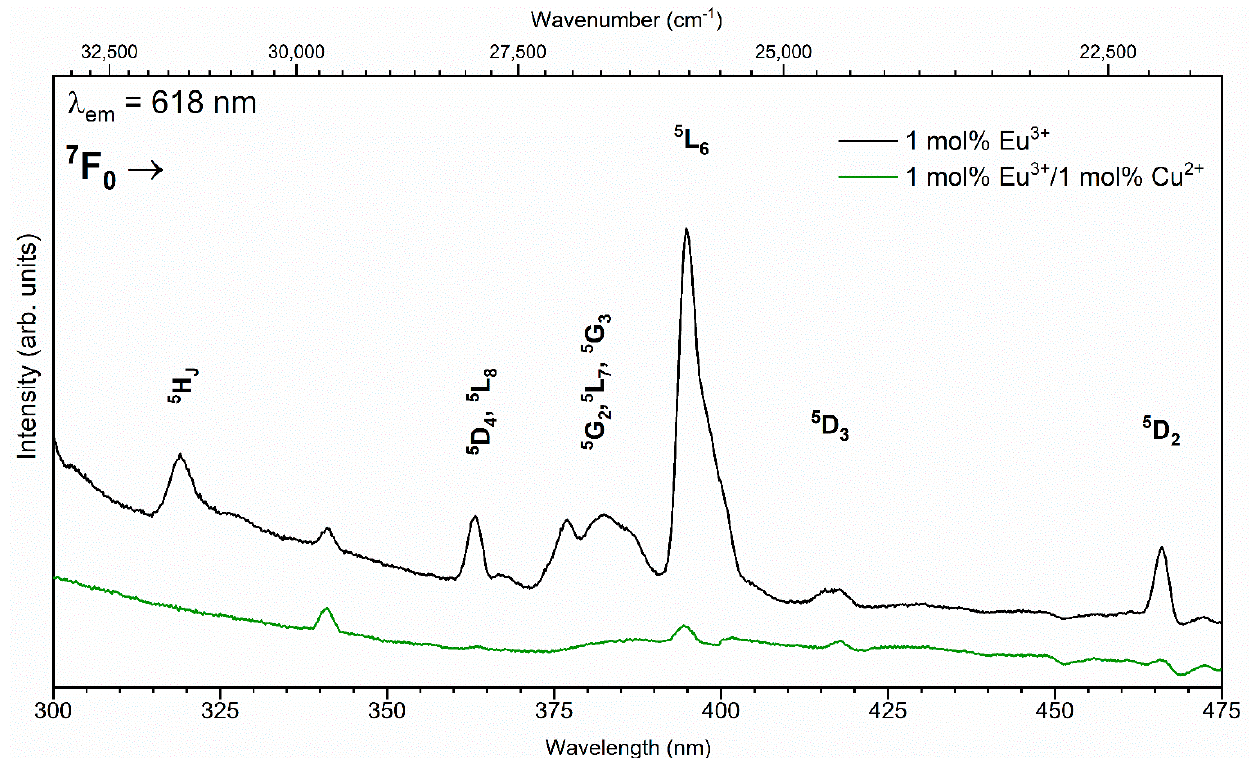
Figure 6. The excitation spectra of the 1 mol% Eu 3+ and 1 mol% Eu 3+ /1 mol% Cu 2+ -co-doped Ca 10 (PO 4 ) 6 (OH) 2 . The spectroscopic properties of Eu 3+ ions allow us to receive vital information about the symmetry of the Eu 3+ ions surrounding the crystal lattice; the amount of crystallo- graphic positions; and therefore, potential sites of substitution, structural changes occur- ring in the matrix caused by external factors, etc. The emission spectra of the Eu 3+ ions consist of characteristic bands present in the red region of the electromagnetic radiation assigned to the electron transitions developing in the 4f-4f shell of Eu 3+ ions. The 5 D 0 → 7 F 0,1,2 transitions are the most important in analysis, particularly in correlation with the structural properties. The 5 D 0 → 7 F 0 transition can provide direct information about the number of crystallographic sites occupied by Eu 3+ ions in the host lattice [19]. The emission spectra of y mol% Eu 3+ :HAp (where y—0.5, 1, and 3 mol%) and x mol% Eu 3+ /y mol% Cu 2+ :HAp (where x—0.5, 1, and 4 mol% and y—0.5 and 1 mol%) were meas- ured by excitation wavelength at 266 nm at room temperature and are shown in Figure 7. The spectra were normalized to the 5 D 0 → 7 F 1 magnetic dipole transition. The emission spectra were dominated by an intense red emission band situated at about 618 nm corre- sponding to the 5 D 0 → 7 F 2 transition of Eu 3+ ions. Meanwhile, four weaker emission bands peaking at around 578, 589, 652, and 698 nm were also detected and ascribed to the 5 D 0 → 7 F 0 , 5 D 0 → 7 F 1 , 5 D 0 → 7 F 3 , and 5 D 0 → 7 F 4 transitions of Eu 3+ ions, respectively [31,35]. The presence of a 5 D 0 → 7 F 0 transition confirms that europium ions are located in a low- symmetry environment. Furthermore, the number of lines directly indicate the number of occupied crystallographic positions in the investigated lattice by Eu 3+ ions. In the apatite molecule, ten calcium atoms are found in two non-equal crystallographic positions, in agreement with the results showed in Figure 7. In Figure 8, the time-resolved emission spectrum of the 1 mol% Eu 3+ /1 mol% Cu 2+ :HAp is presented.